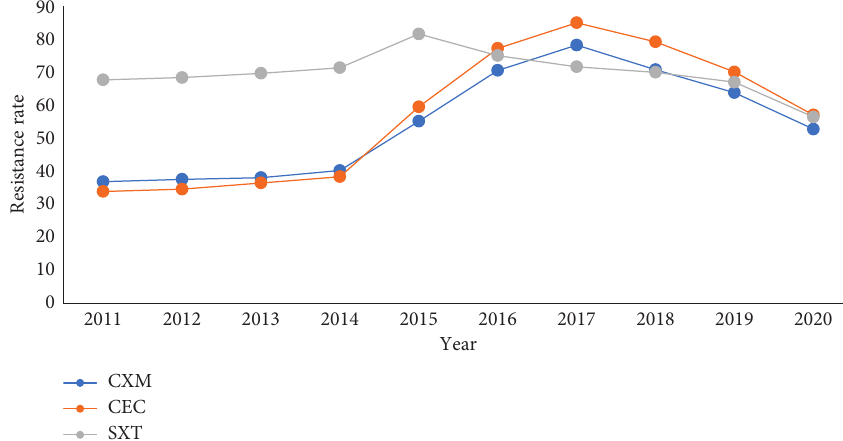
Figure 17: Changes in drug resistance of H. influenzae from 2011 to 2020